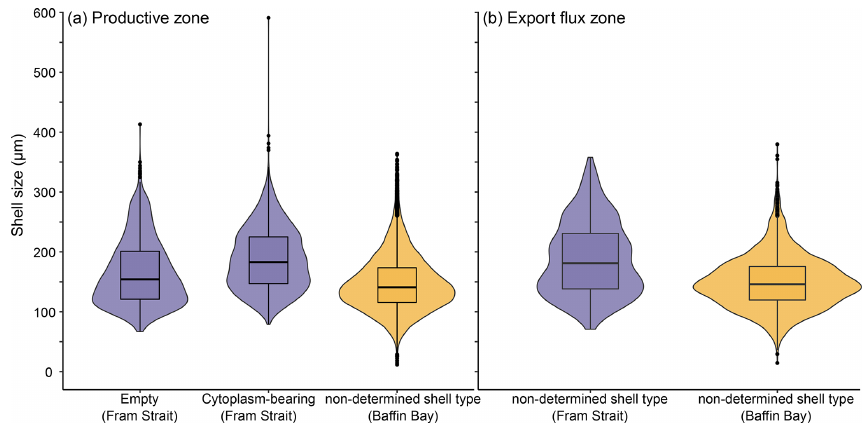
Figure 4. Overview of shell sizes of N. pachyderma from the Fram Strait (blue) and Baffin Bay (orange), contrasting empty, cytoplasm- bearing and non-determined shells (a) within the productive zone and (b) in the export flux zone. Shell types are also not distinguished in (b) in samples from the Fram Strait, as we assume all shells collected below the productive zone to represent specimens that were dead during retrieval. The boxes and bars represent the interquartile range as explained in the caption of Fig. 3.